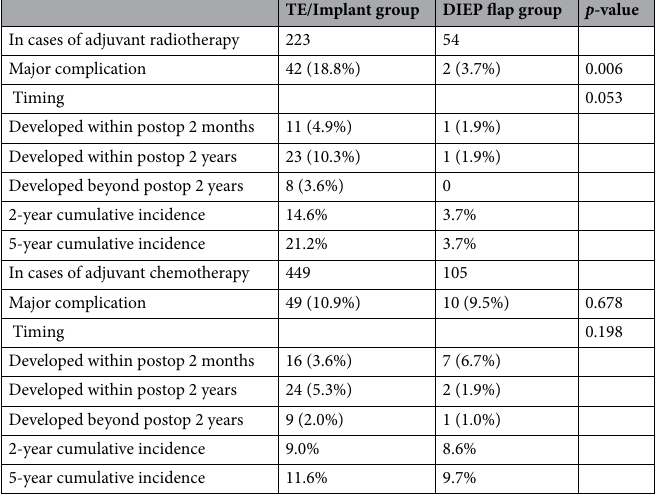
TE/Implant group DIEP flap group p-